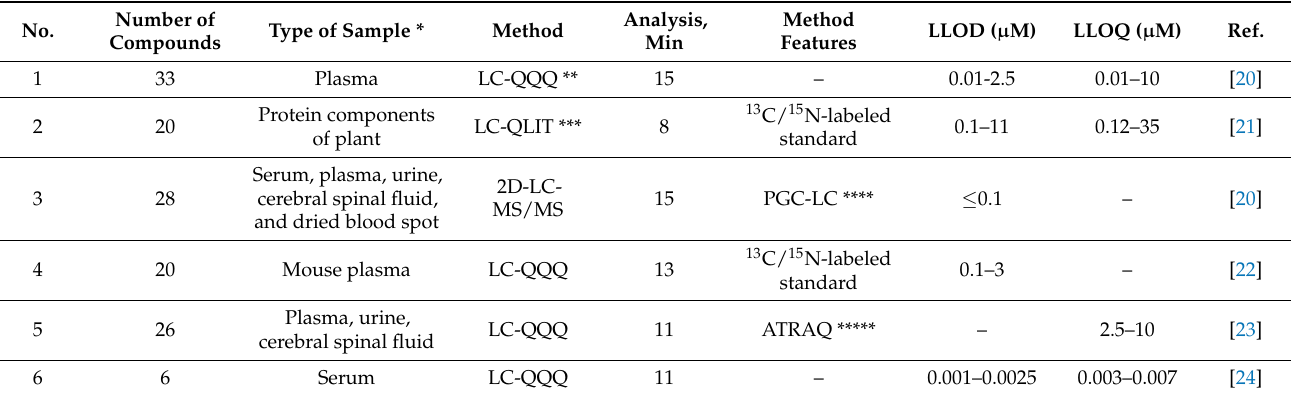
Table 1. Comparative analysis of HPCL-MS/MS approaches for quantitative detection of amino acids in biological